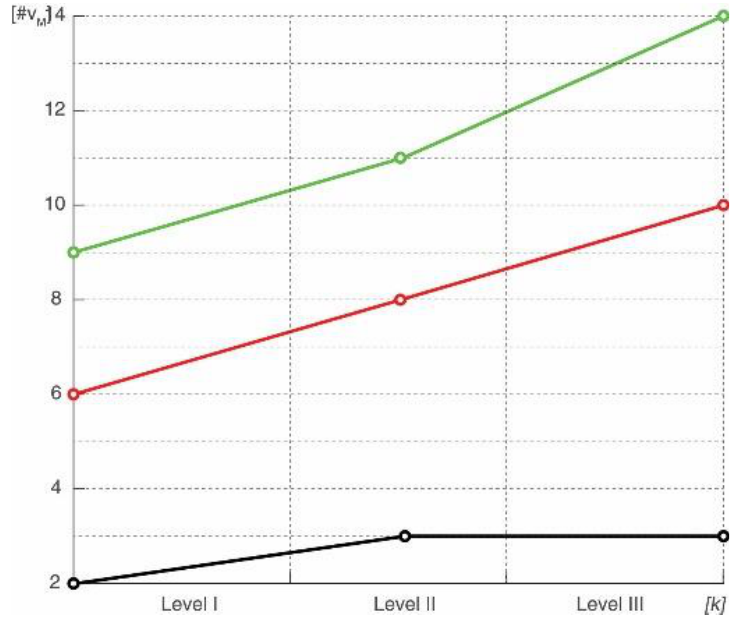
Figure 6. The number of matched vertices using quantization levels k = [ 2, 3, 4 ] . The shown values vary depending on the selected tolerance and the total number of selected vertices (Table 2). Table 2. Matching accuracy depending on quantization levels and extraction tolerance.